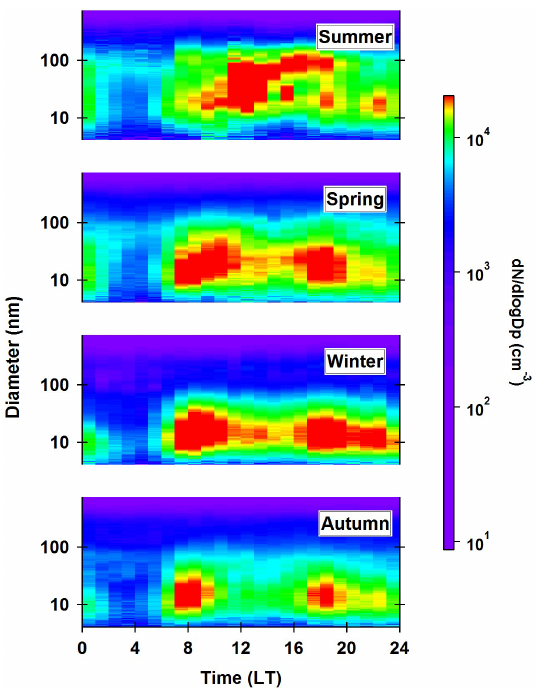
Figure 5. Diurnal variation of particle number size distribution in each season. From the lower panel to the top panel: autumn, winter, spring and summer.